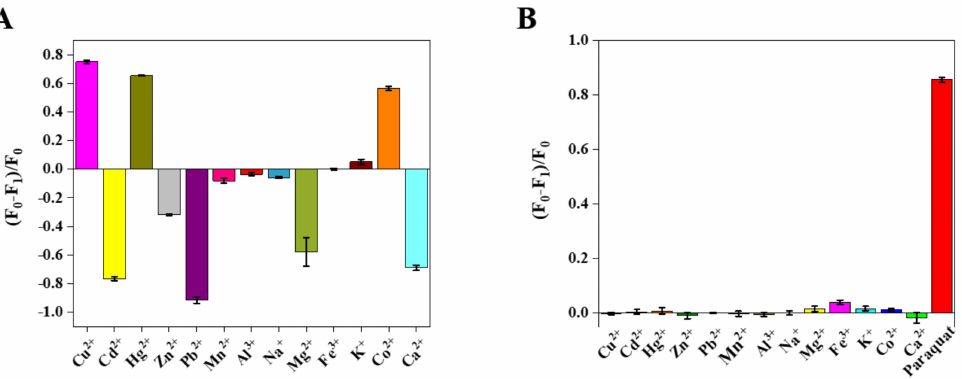
Figure 6. The interference evaluation of metal ions in paraquat sensing. ( A ) The response of metal ions to GSH/ β -CDs- AuNCs. ( B ) The interference of metal ions in the presence of 100 µ M EDTA. All the concentrations of metal ions, including Cu 2+ , Cd 2+ , Hg 2+ , Zn 2+ , Pb 2+ , Mn 2+ , Al 3+ , Na + , Mg 2+ , Fe 3+ , K + , Co 2+ , and Ca 2+ , were 10 µ